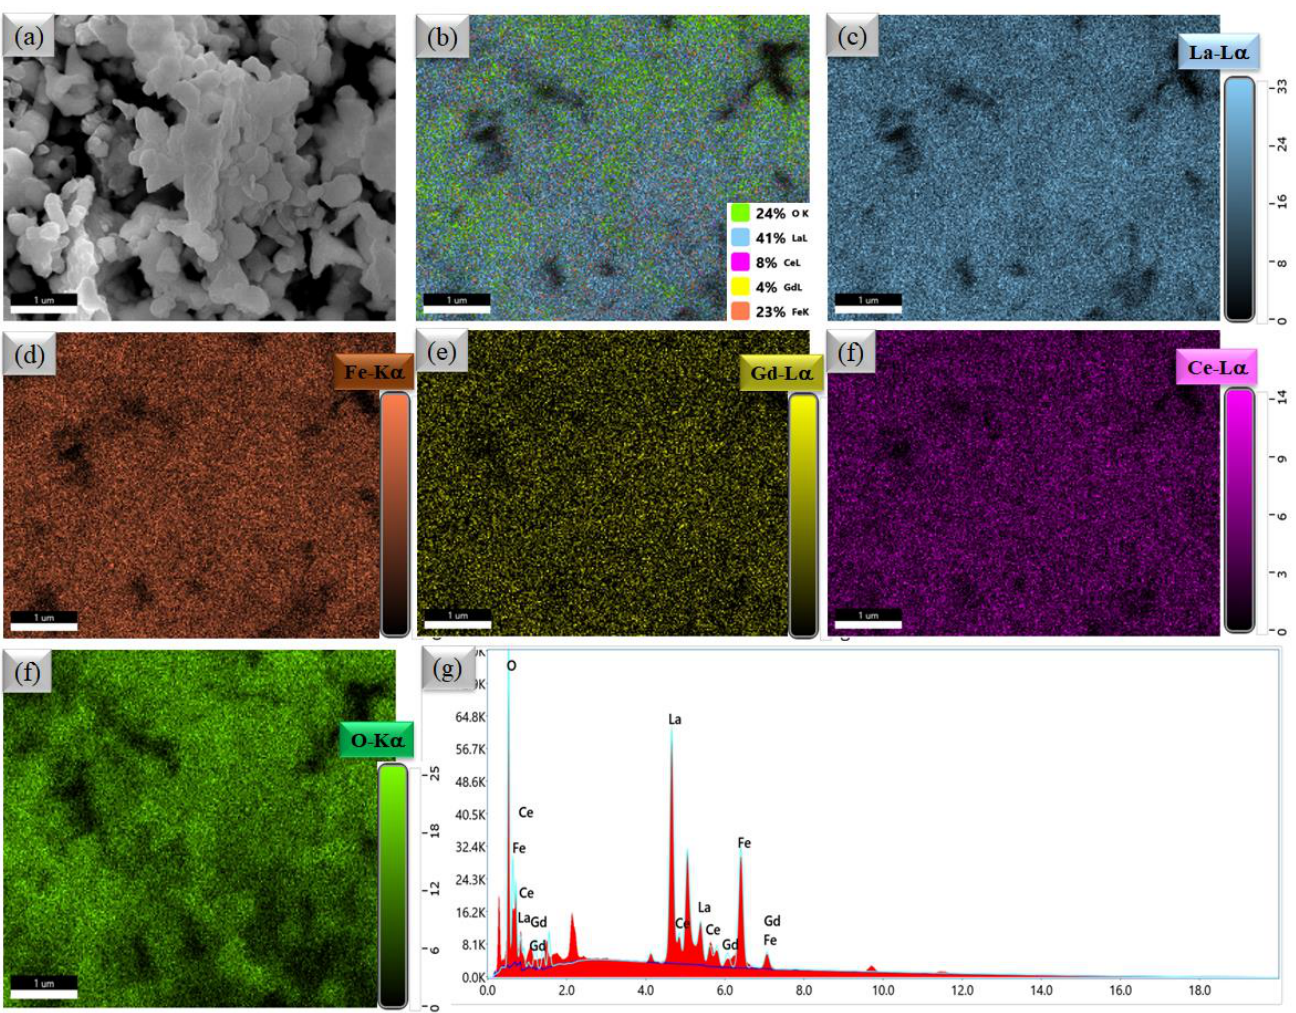
Figure 2. ( a , b, c d, e and f ) The surface morphology studied by SEM for LaFe 0.8 Gd 0.1 Ce 0.1 O 3- δ powder at different scale of 10 – 500nm.